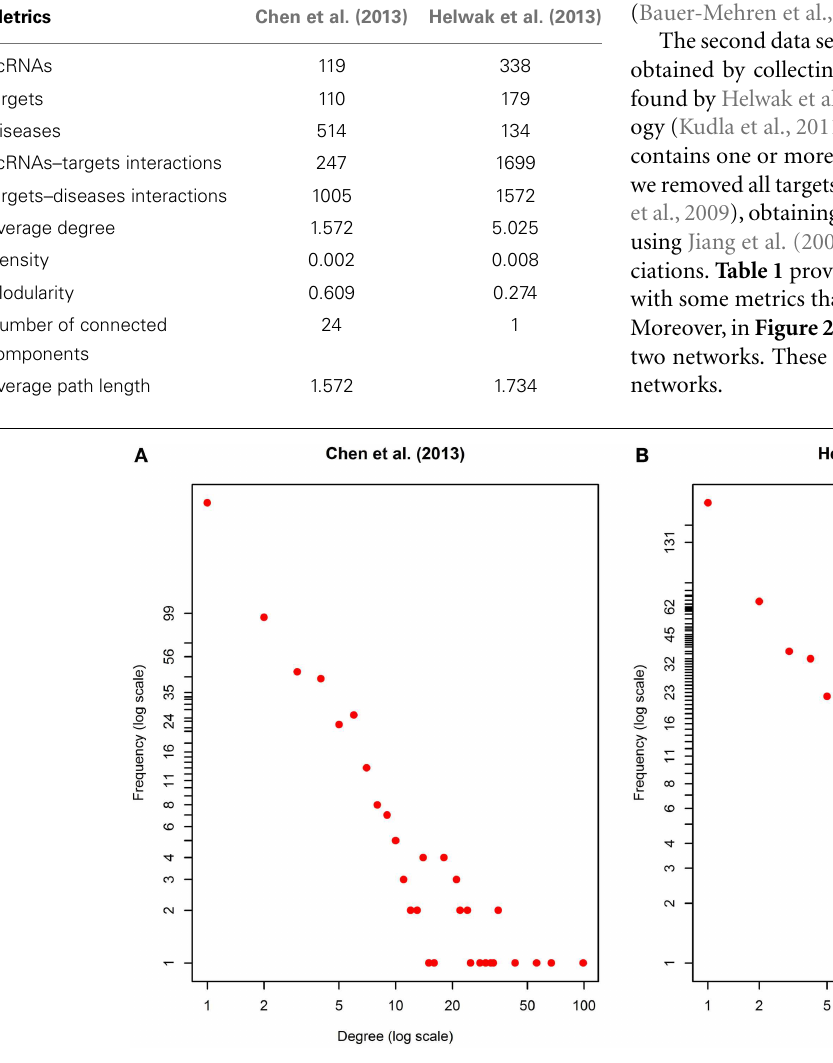
FIGURE 2 | Degree distribution of the two networks used as datasets : (A) Chen et al. (2013), (B) Helwak et al. (2013).The two plots are in log-log scale. As can be seen the degree distribution for the two networks can be approximated to an exponential one.We can therefore assume that the two networks are